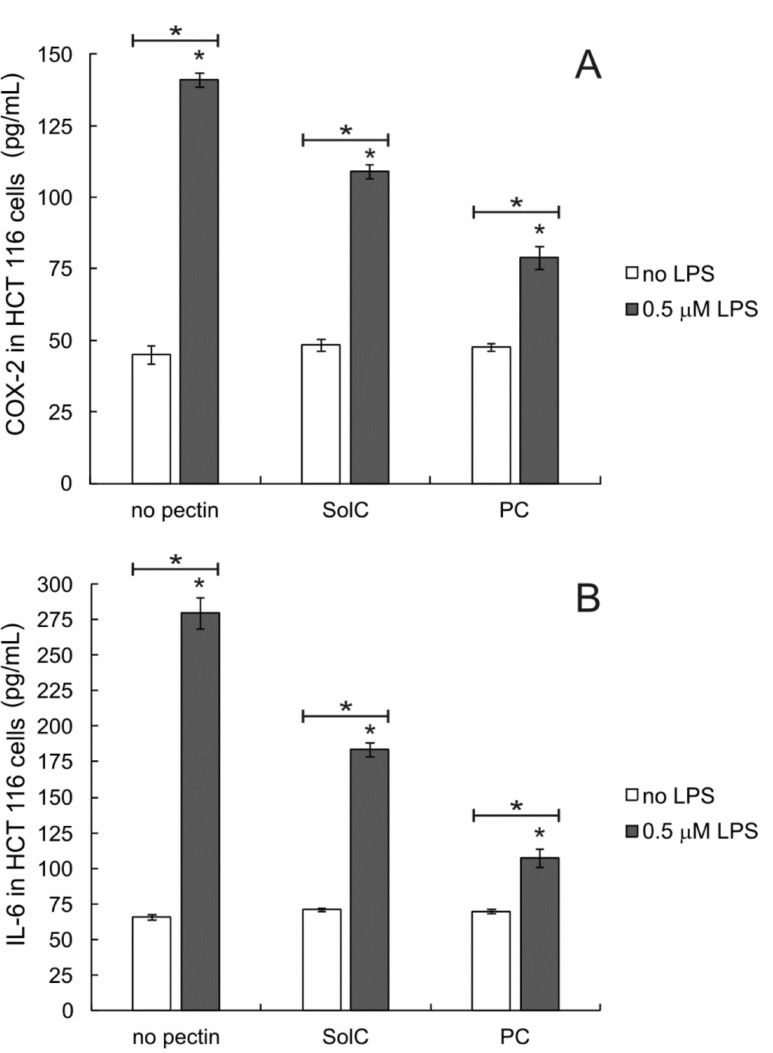
Figure 6. Amount of COX-2 ( A ) and IL-6 ( B ) in HCT 116 cells treated with 0.2 mg/mL pectins and/or 0.5 µ M LPS. Cells were pretreated with LPS for 24 h and then incubated with pectins for 48 h. The means of three experiments ± SD are presented (* p < 0.05). Statistical significance was checked between the studied probes and controls (no pectin) as well as between probes containing only pectin and pectin combined with